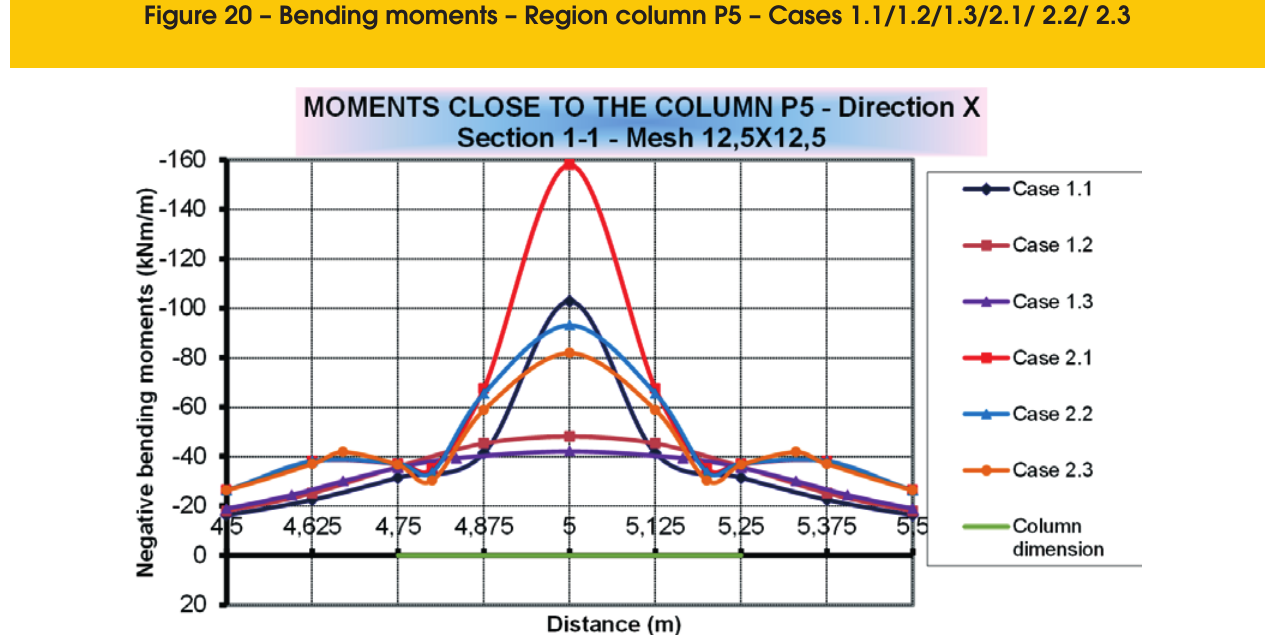
Figure 20 – Bending moments – Region column P5 – Cases 1.1/1.2/1.3/2.1/ 2.2/ 2.3